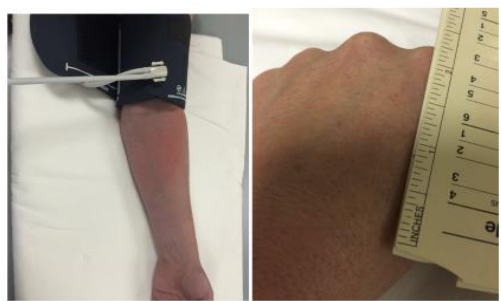
Figure 5. The tourniquet test, which is a marker of capillary fragility, is a quick and easy bedside study that can help physi- cians differentiate dengue from other illnesses, although it lacks both sensitivity and specificity. A blood pressure cuff is inflated to midway between the systolic and diastolic blood pressure and maintained for five minutes. A positive test is the presence of 10 or more petechiae per square inch.